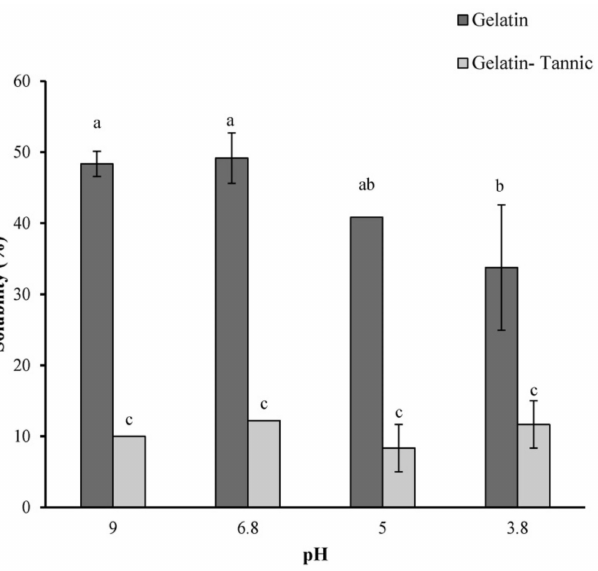
Figure 6. Solubility of pure and tannic acid-crosslinked gelatin nanofiber mats at different pH values. Different letters above column shows significant differences at p < 0.05. Reprinted from [70]. Copyright 2021